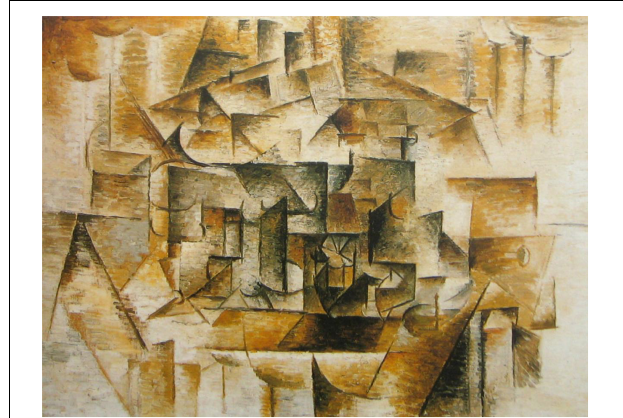
FIGURE 1 | A reproduction of a painting by Pablo Picasso from 1910. ©Succession Picasso/DACS, London 2022.